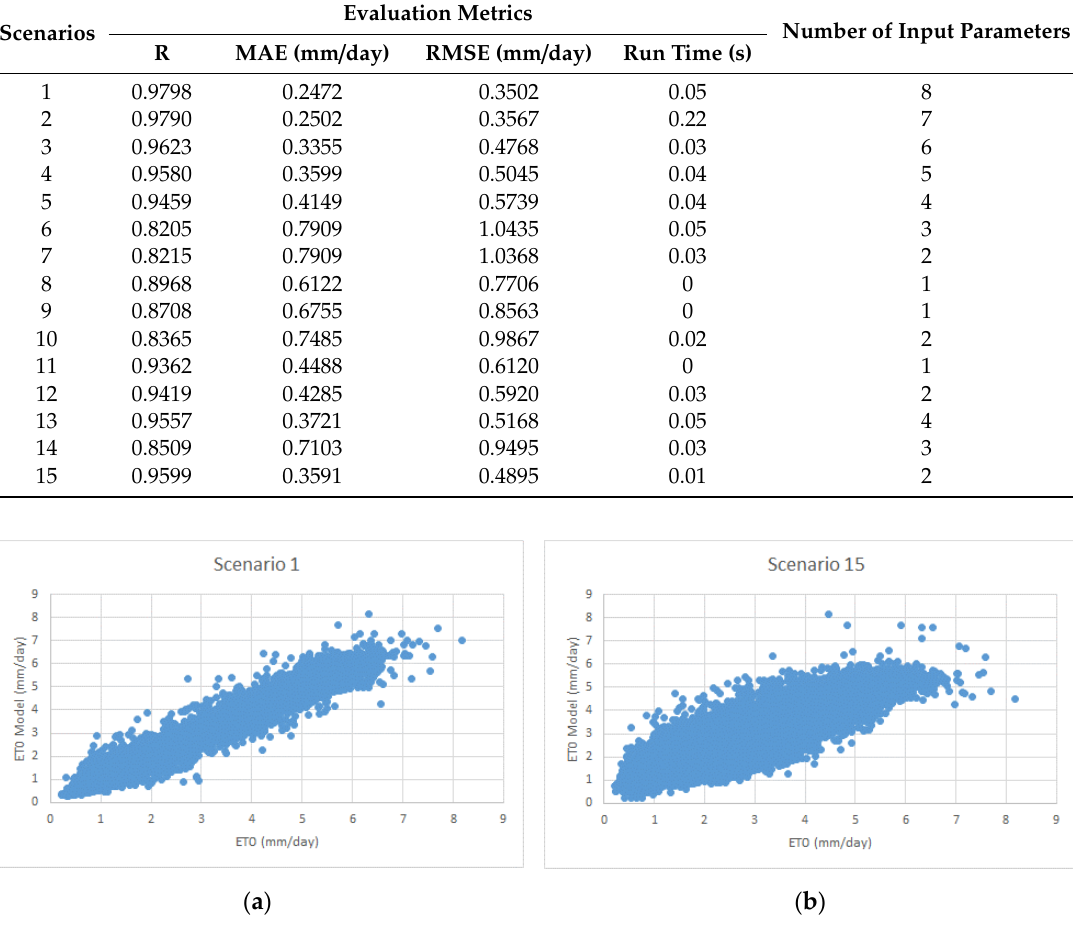
Table 7. REPTree model results for different scenarios.